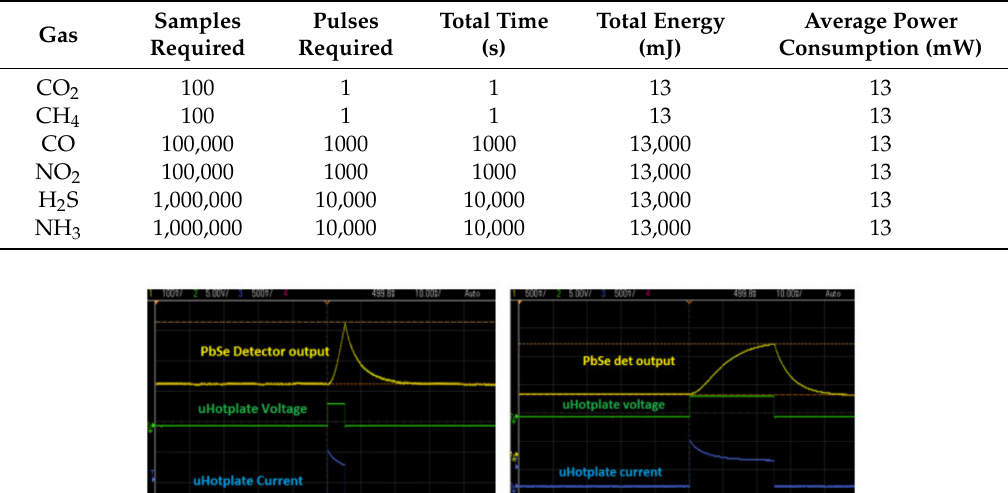
Table 2. Power requirements for a single measurement of di ff erent gases.